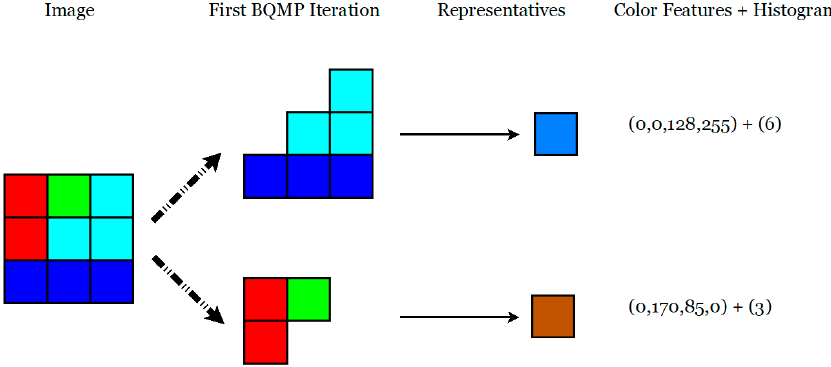
Figure 5. First binary quaternion-moment-preserving (BQMP) iteration example for the case of four different colors. Numbers show the color coded in (q 0 , q 1 , q 2 , q 3 ) and the number of pixels for each color representative (histogram).